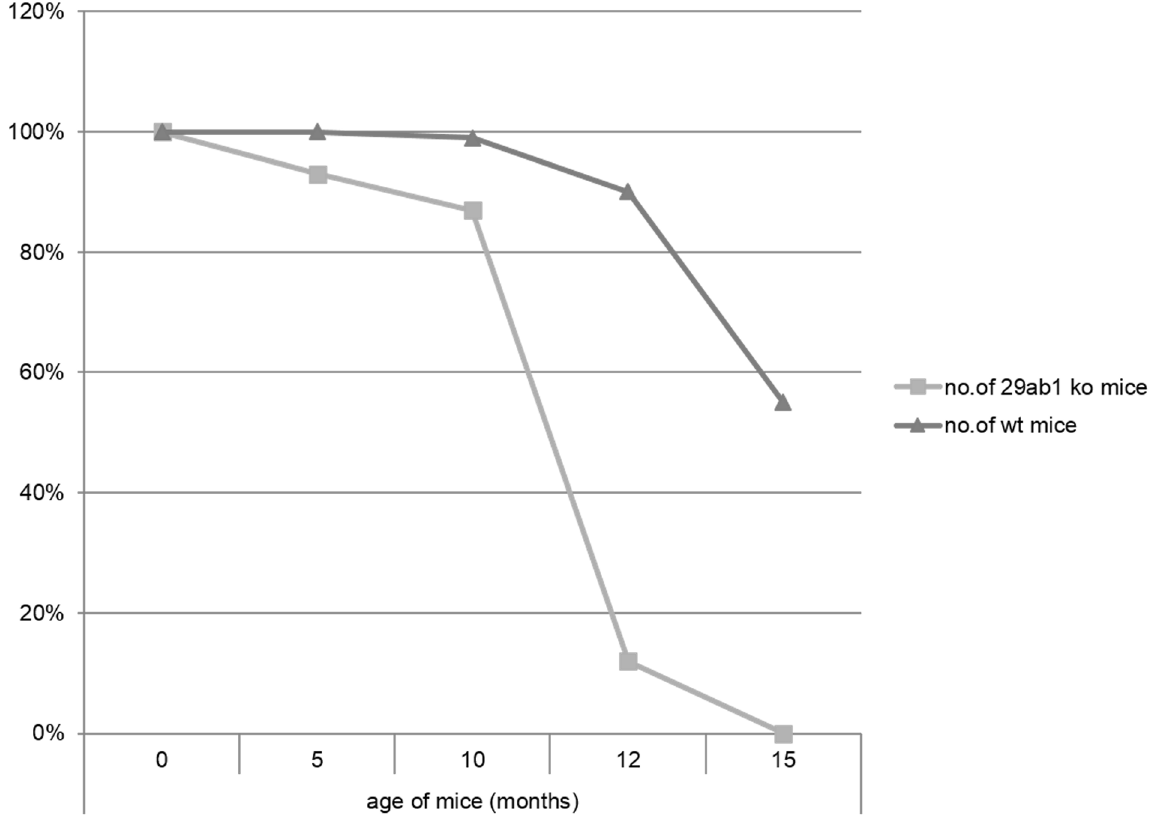
Fig 2. Kaplan-Meyer survival chart for 29ab1 ko mice.